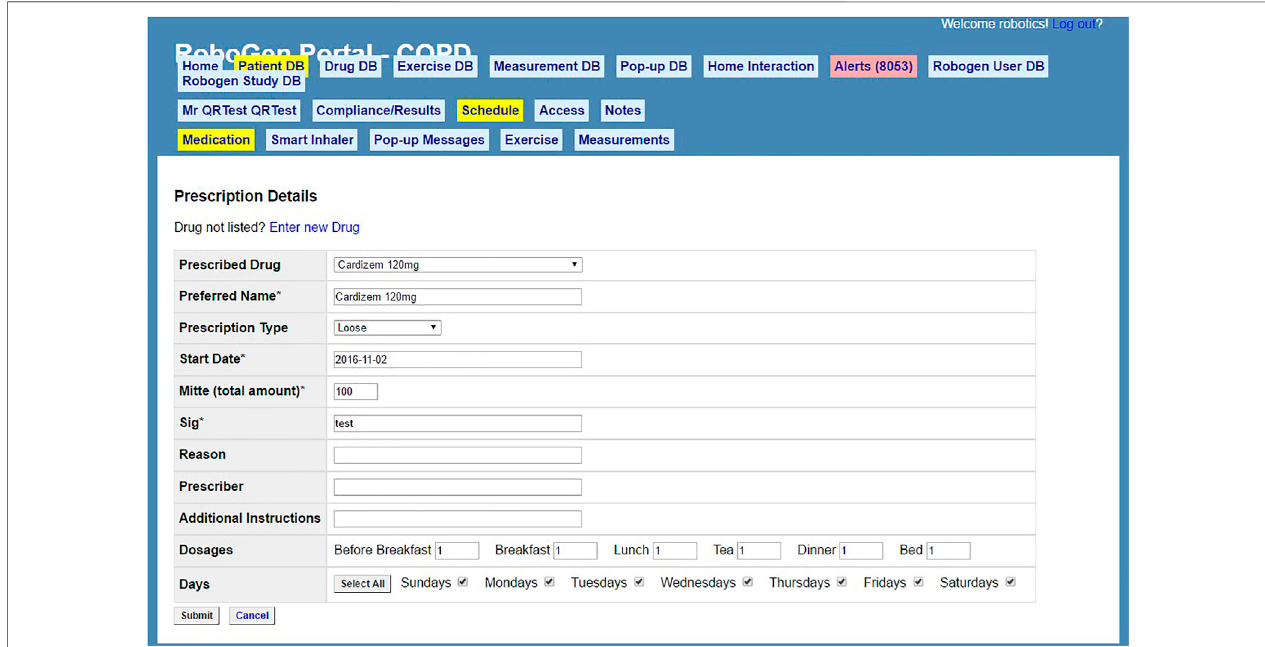
FIGURE 1 | RoboGen user interface: medication